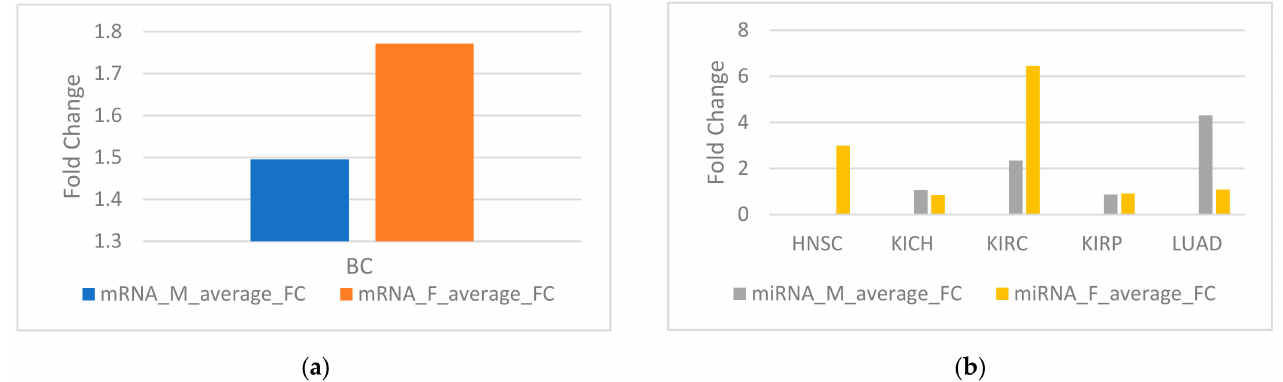
Figure 2. ( a ) Average fold change (FC) for sex-biased genes in breast cancer (BC). ( b ) Average FC for sex-biased miRNA in five TCGA cancers.